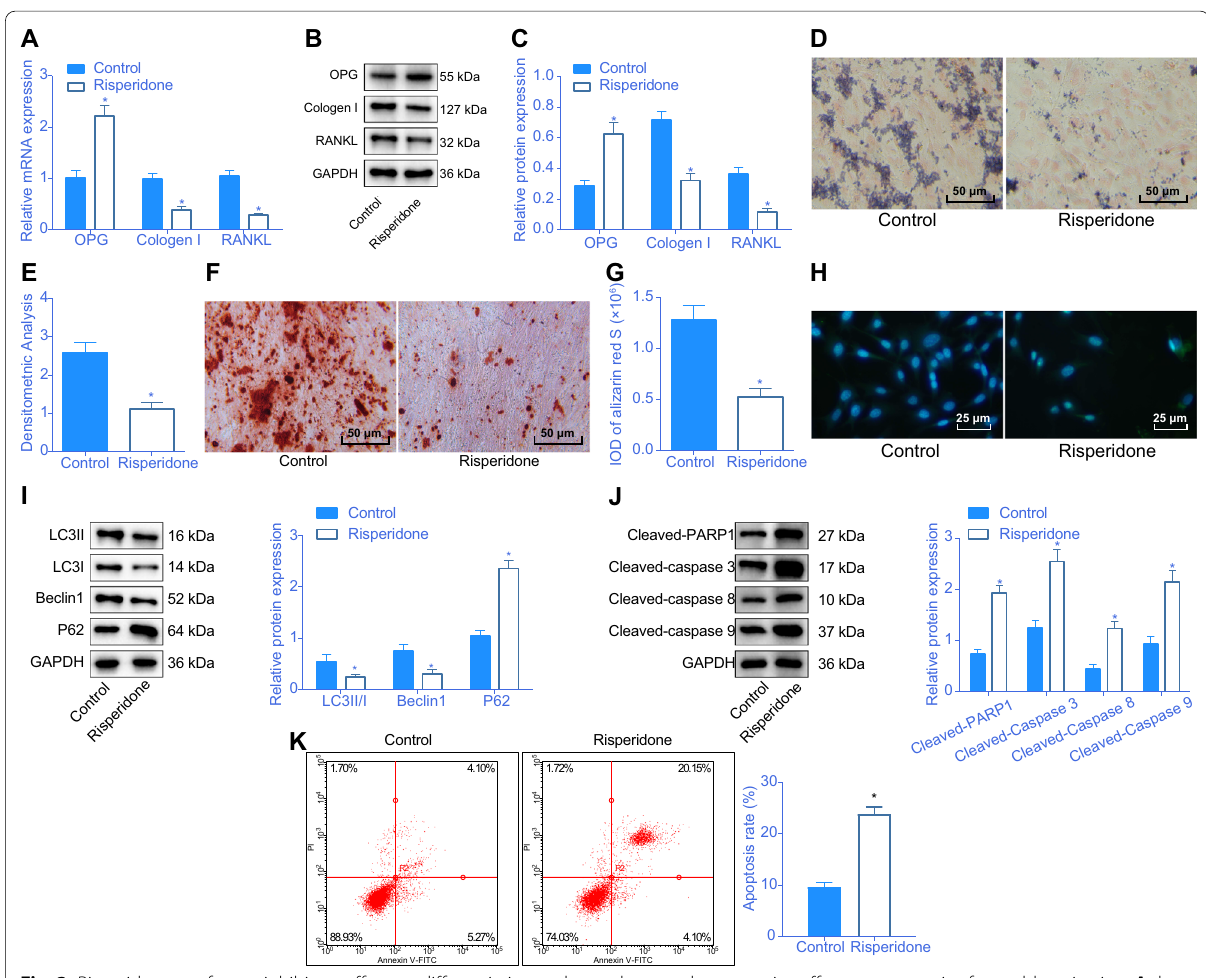
Fig. 3 Risperidone confers an inhibitory effect on differentiation and autophagy and a promotive effect on apoptosis of osteoblasts in vitro. A the mRNA expression of OPG, collagen I and RANKL in MC3T3-E1 cells determined by RT-qPCR. B – C Western blot analysis of differentiation-related protein (OPG, collagen I and RANKL) expression in MC3T3-E1 cells. The band intensity was assessed. D representative images of ALP staining in MC3T3-E1 cells. E, statistical results of ALP positive rate in MC3T3-E1 cells. F representative images of alizarin red S staining in MC3T3-E1 cells. G statistical results of integrated optical density (IOD) of alizarin red S in MC3T3-E1 cells. H representative images of autophagosome in MC3T3-E1 cells assessed by immunofluorescence. I Western blot analysis of autophagy-related protein (LC3 II/I, Beclin1, and p62) expression in MC3T3-E1 cells. The band intensity was assessed. J Western blot analysis of apoptosis-related protein (cleaved PARP1, cleaved caspase-3, cleaved caspase-8 and cleaved caspase-9) expression in MC3T3-E1 cells. K apoptosis rate in MC3T3-E1 cells evaluated by flow cytometry. * p < 0.05, compared with MC3T3-E1 cells treated with normal culture medium. The cell experiments are repeated 3